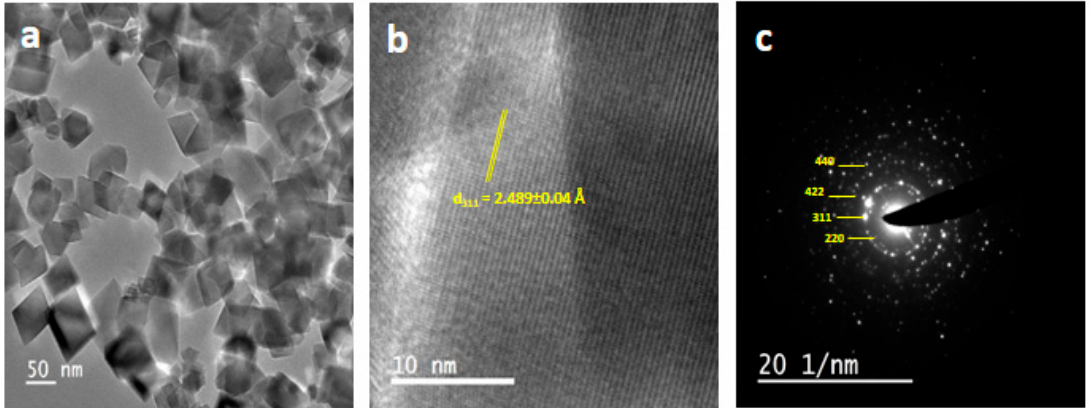
Figure 2. ( a ) TEM micrograph, ( b ) HR-TEM image and ( c ) SAED pattern of MIONPs.